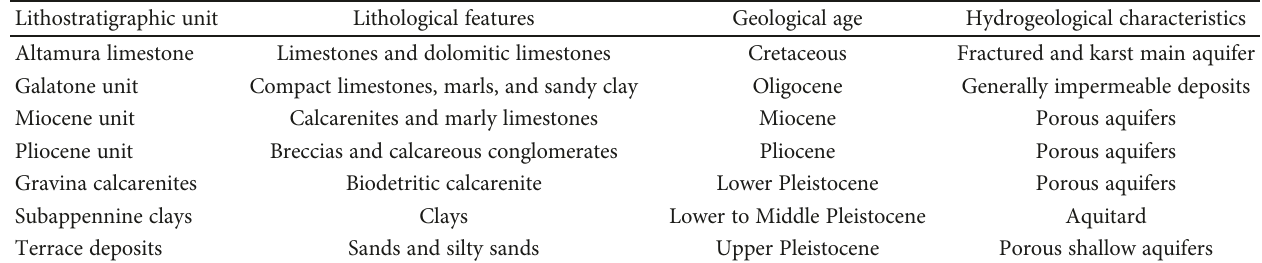
Table 1: List of the lithostratigraphic units identi fi ed and their hydrogeological characteristics (modi fi ed after De Filippis et al.